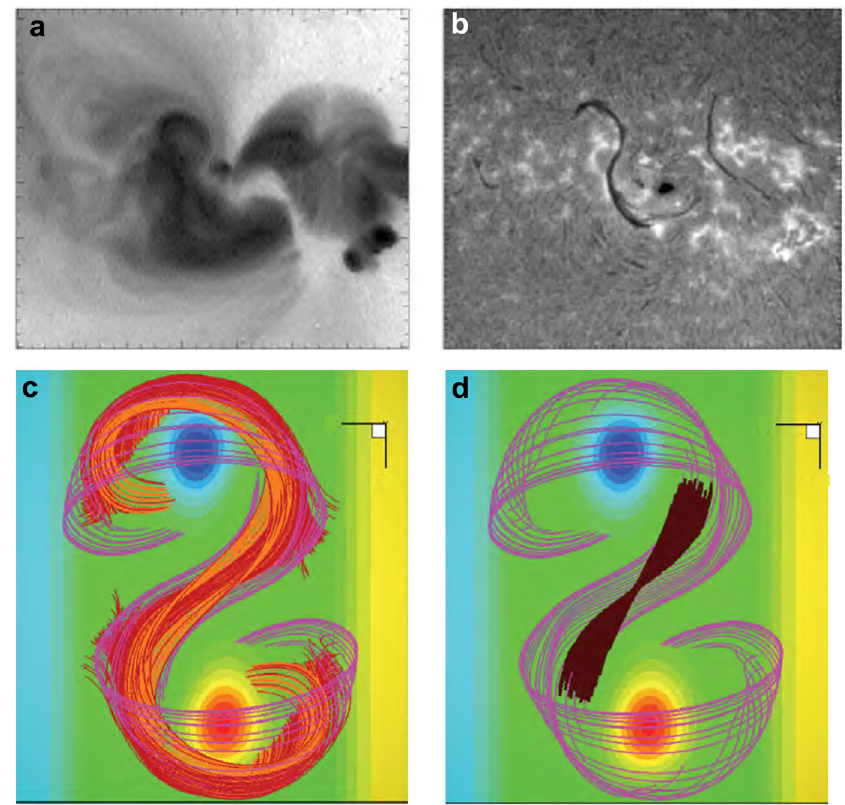
Fig.10 Aflux-ropemodelfilamentliesaboveandwithintheBPSSidentifiedwithaSXRsigmoid. a Yohkoh SXT (inverse color scale) and b Big Bear Solar Observatory (BBSO) observations of a SXR sigmoid and H α sigmoidal filament. Image reproduced with permission from Gibson et al. (2002), copyright by AAS. c Flux rope with BPSS (purple) and current-sheet-intersecting field lines (red/orange). Orange field lines in c have dips, and d paints the centers of these and other dipped field lines up to a prominence scale height (brown). Image reproduced with permission from Gibson and Fan (2006a), copyright by